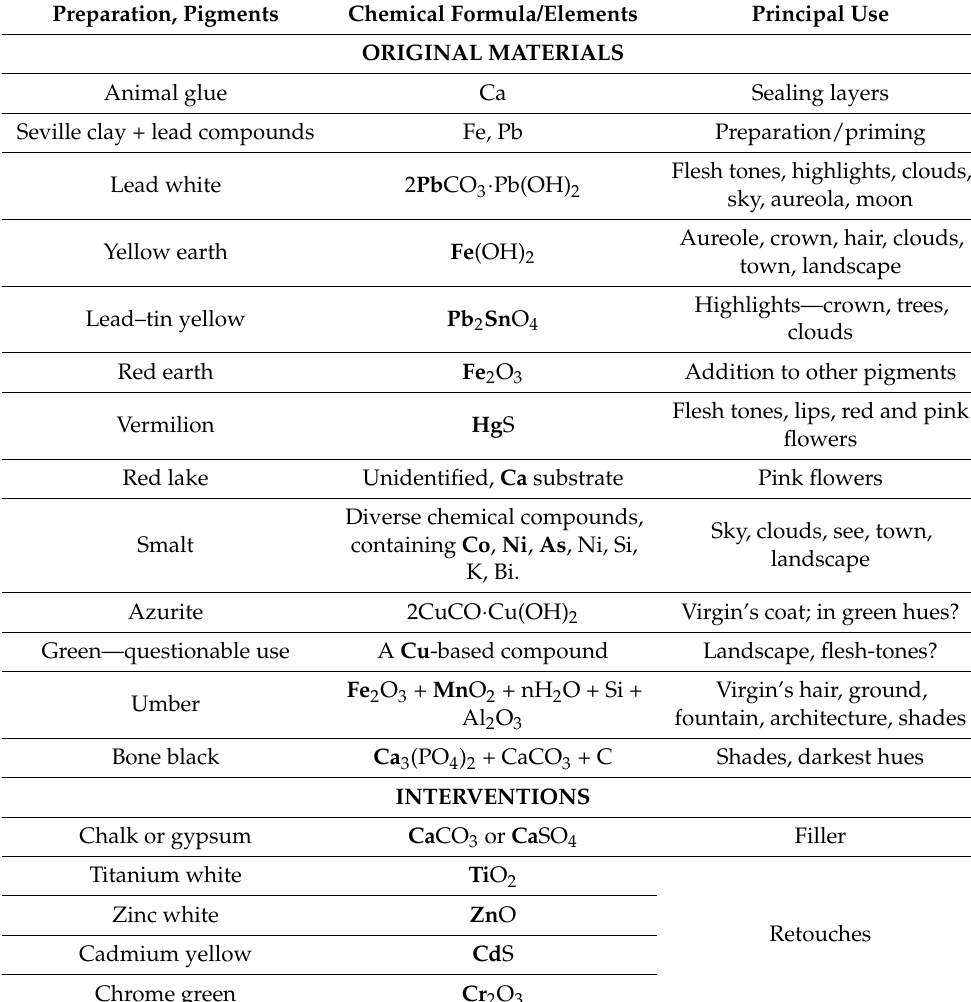
Table 1. Systematic representation of original and modern materials identified in La Inmaculada by XRF, with characteristic chemical elements for each material in